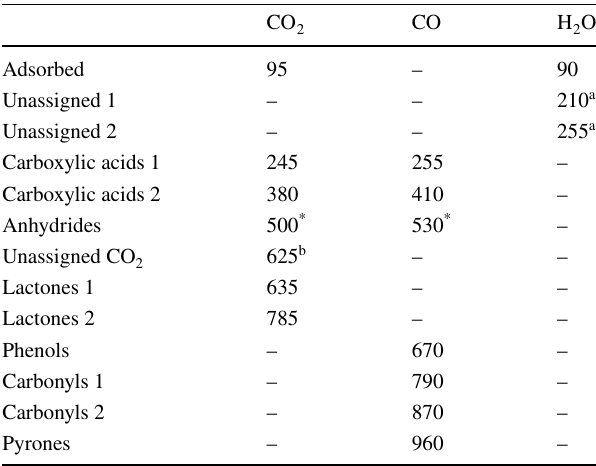
Table 2 Assignment of CO 2 , CO, and H 2 O to surface oxygen